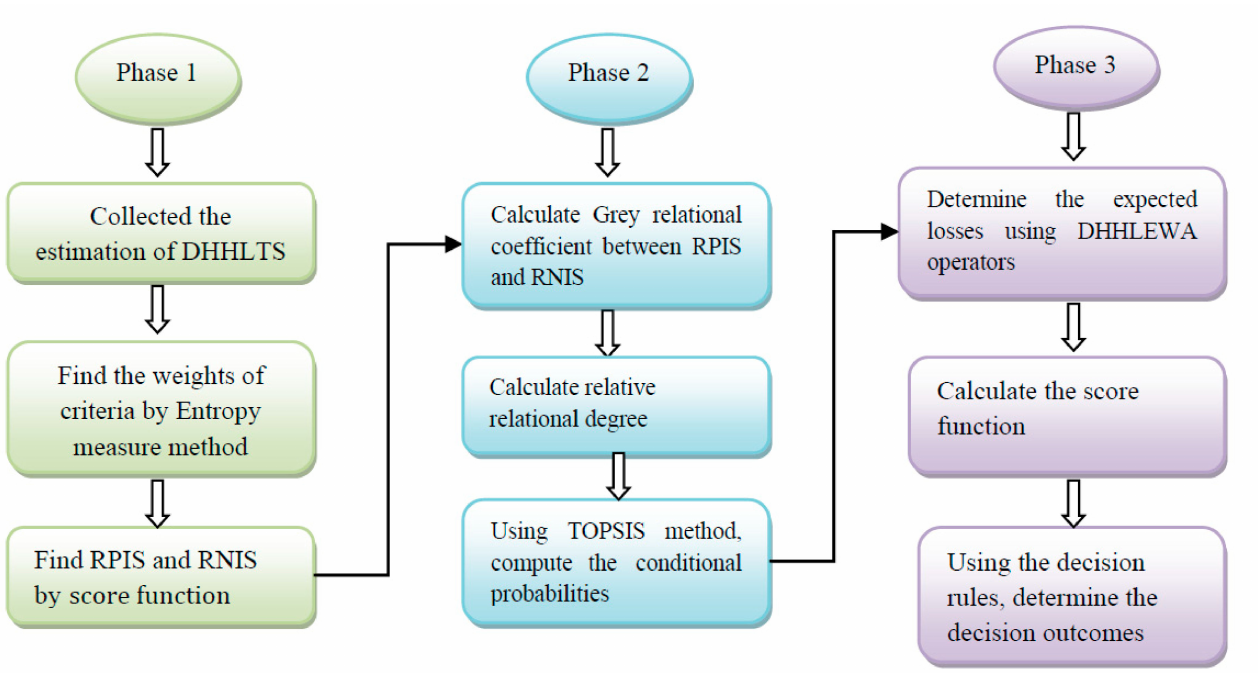
Figure 1. The suggested procedure. The double hierarchy hesitant linguistic term information system (DHHLTIS); the double hierarchy hesitant Einstein weights averaging (DHHLEWA); the technique for order of preference by similarity to ideal solution (TOPSIS)